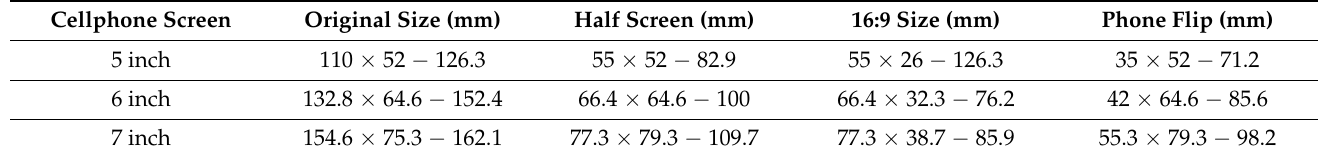
Table 2. Detailed parameters of mobile phone screen.